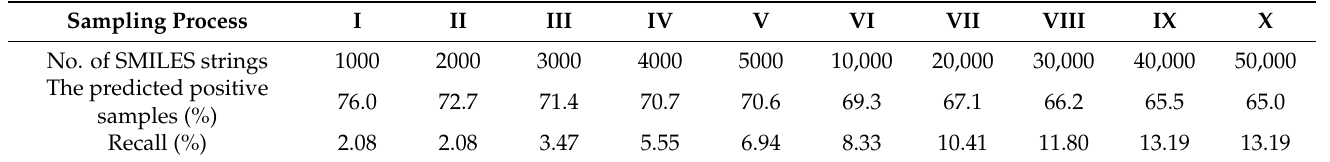
Table 2. The recall value of the 144 caspase-6 inhibitors.